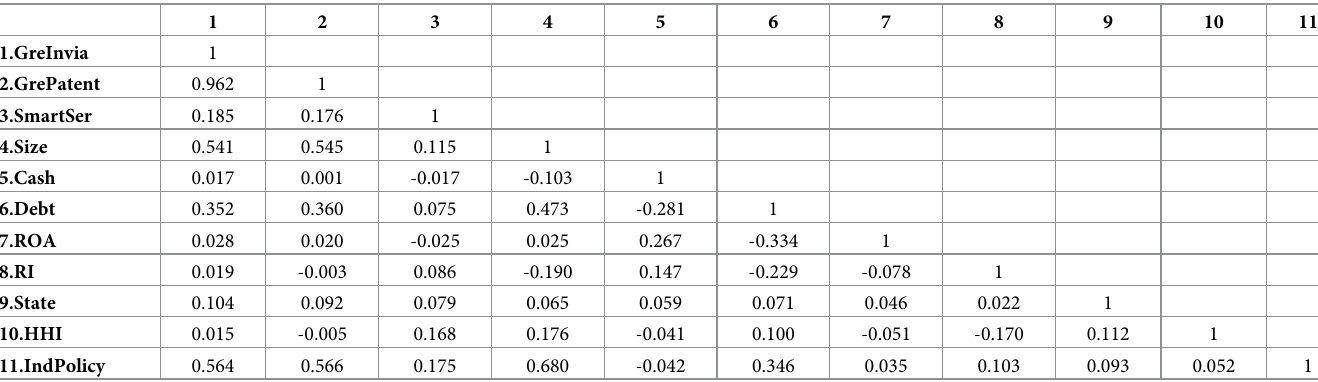
Table 4. Correlation matrix.